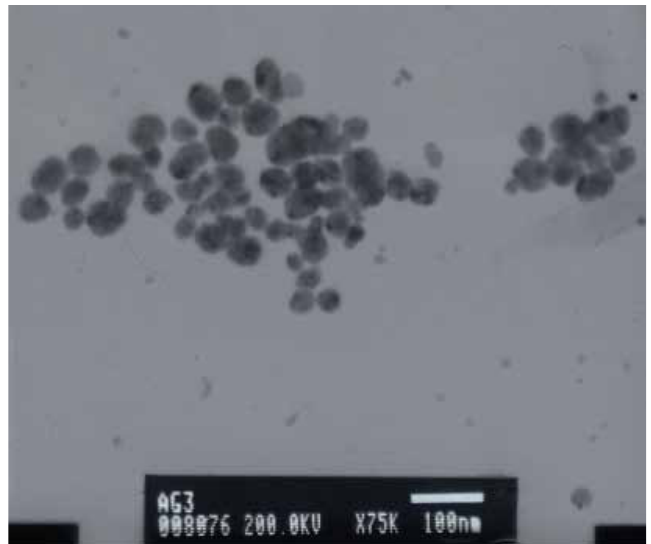
Fig. 1 - Transmission electron microscopy (TEM) micrograph of Ag nanoparticles (scale bar of 100 nm).